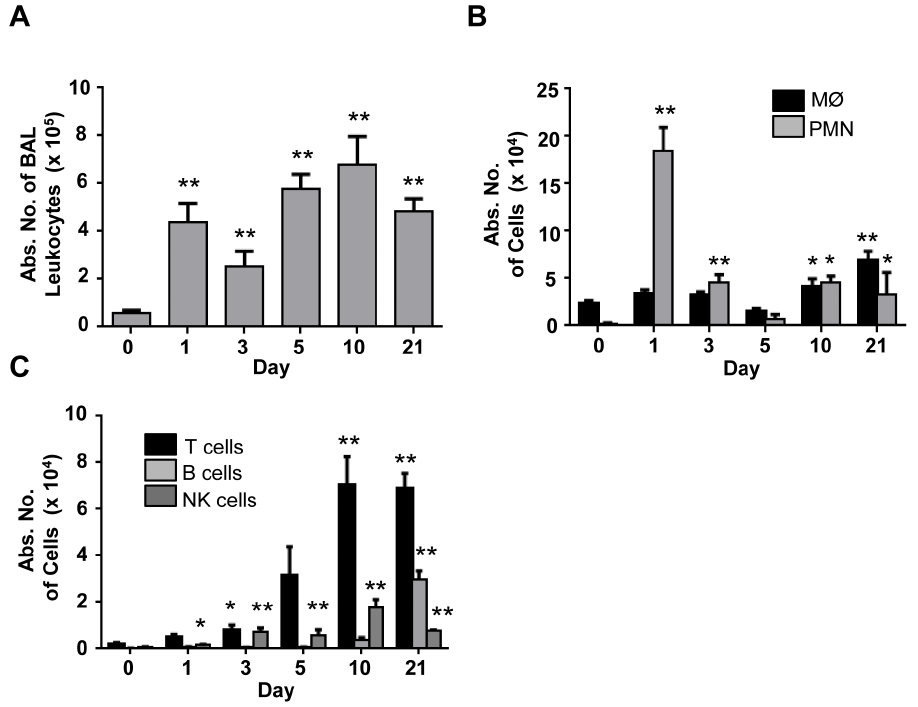
Figure 1. Kinetic analysis of leukocyte migration in the airways in bleomycin treated mice. Leukocytes from BAL fluid were collected on day 0, 1, 3, 5, 10 and 21 after intra-nasal injection of bleomycin (7.5 mg/kg) in WT balb/c mice. A ) The absolute number of leukocytes in BAL fluid was determined by flow cytometry at the indicated time points. B ) The number of macrophages and neutrophils were determined by flow cytometry using specific antibodies against macrophages (F4/80) and neutrophils (Ly6G). C ) The number of T cells (TCR b + ), B cells (CD19 + ), and NK cells (DX5 + TCR b -) were measured in BAL fluid by flow cytometry. n=3–8 mice per time point. *p , 0.05, ** p , 0.01, by ANOVA followed by t-test, comparing indicated time points post-bleomycin injection to t=0.